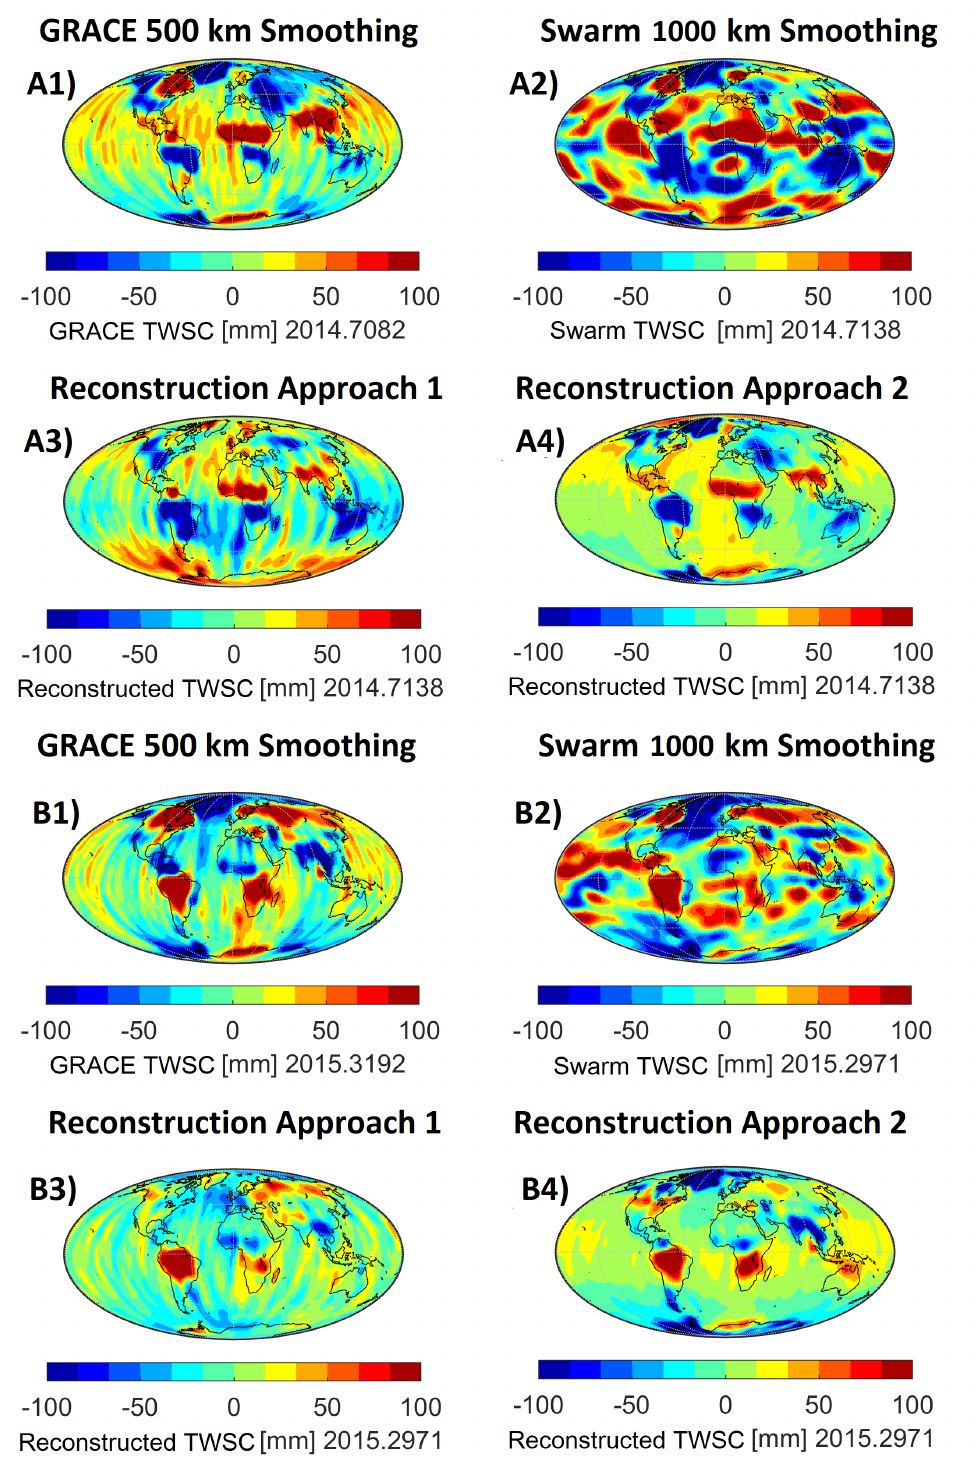
Figure 2. Results of the two reconstruction techniques for the period that both the Gravity Recovery And Climate Experiment (GRACE) and Swarm fields exist; ( A1 , B1 ) show the GRACE fields in 2014.7082 (August 2014) and 2015.3192 (March 2015), respectively, while ( A2 , B2 ) indicate Swarm fields close to A1 and B1 (2014.7138 and 2015.2971); ( A3 , B3 ) represent the reconstruction results of Approach 1; and finally, ( A4 , B4 ) belong to those of Approach